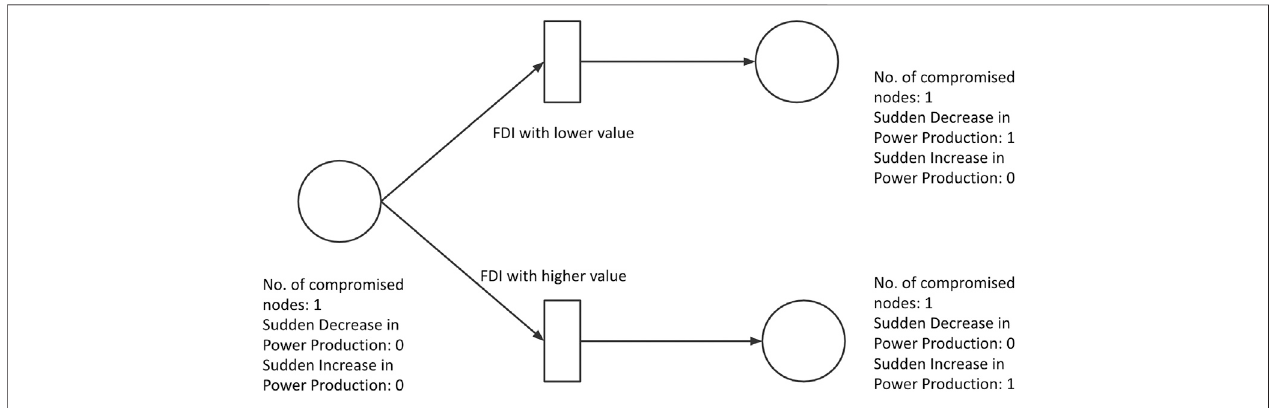
FIGURE 8 | FDI attack aector using Petri